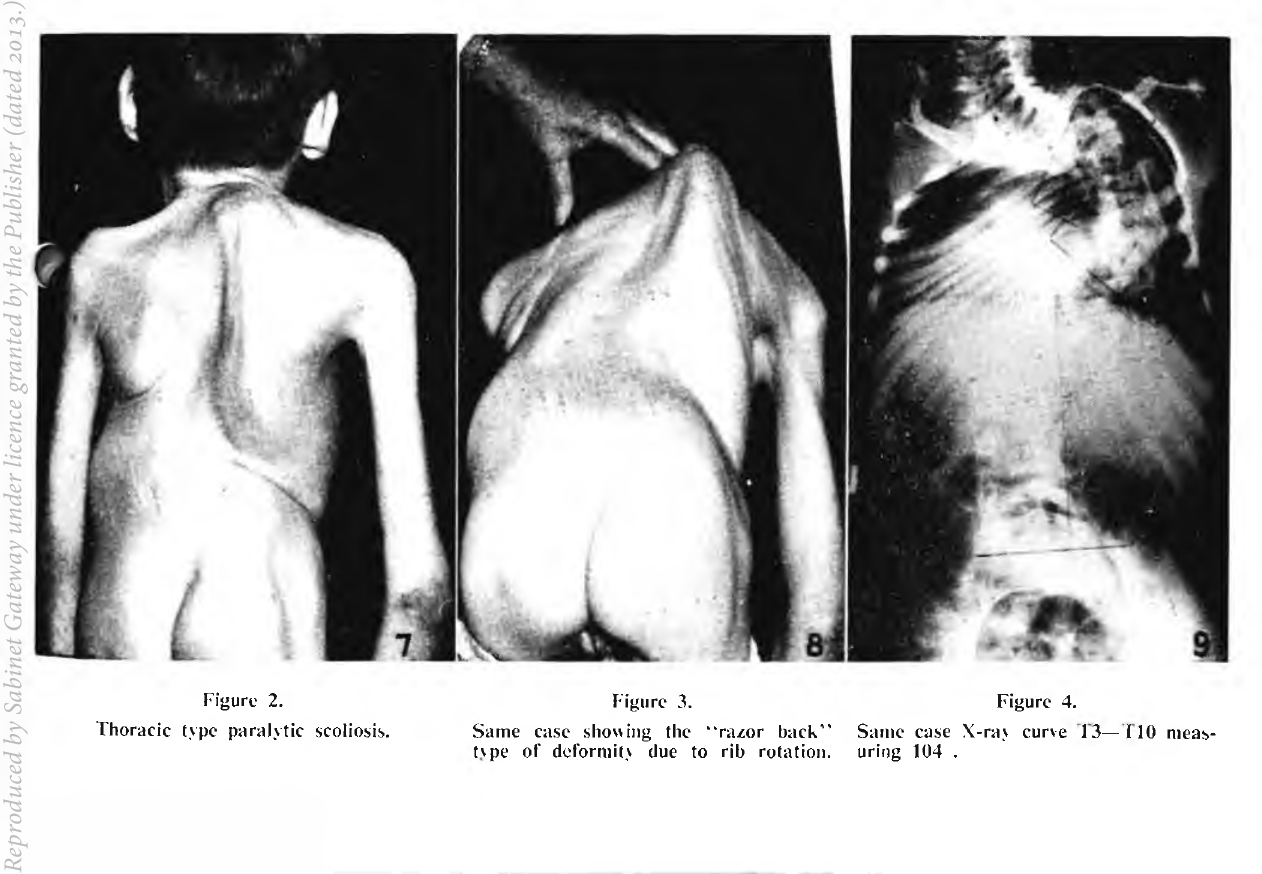
Same ease showing the "razor back” Same case X-ra> curve 13— 110 meas- t\pe of deformity due to rib rotation, uring 104